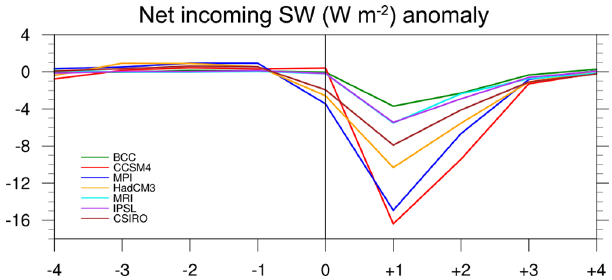
Figure 9. Annual-mean composite anomaly of net shortwave (SW) radiation at the top of the atmosphere for three large volcanic erup- tion events for each GCM. Individual GCM results are aligned so that their peak negative SW anomalies occur at year + 1 (i.e. 1258, 1452, 1815 for BCC, CCSM4, IPSL; 1258, 1452, 1816 for MRI; 1258, 1456, 1816 for MPI, HadCM3,